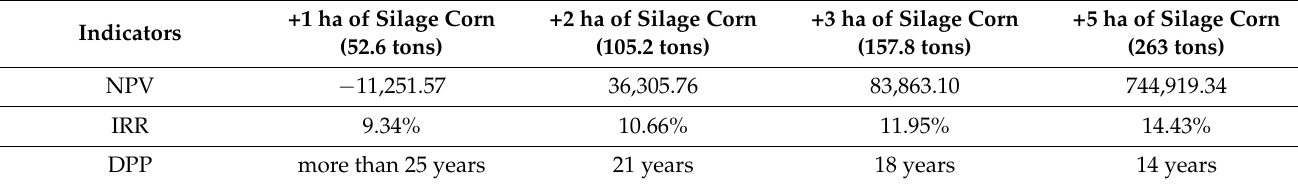
Table 7. Different scenarios of adding corn silage for location Naklo 2.